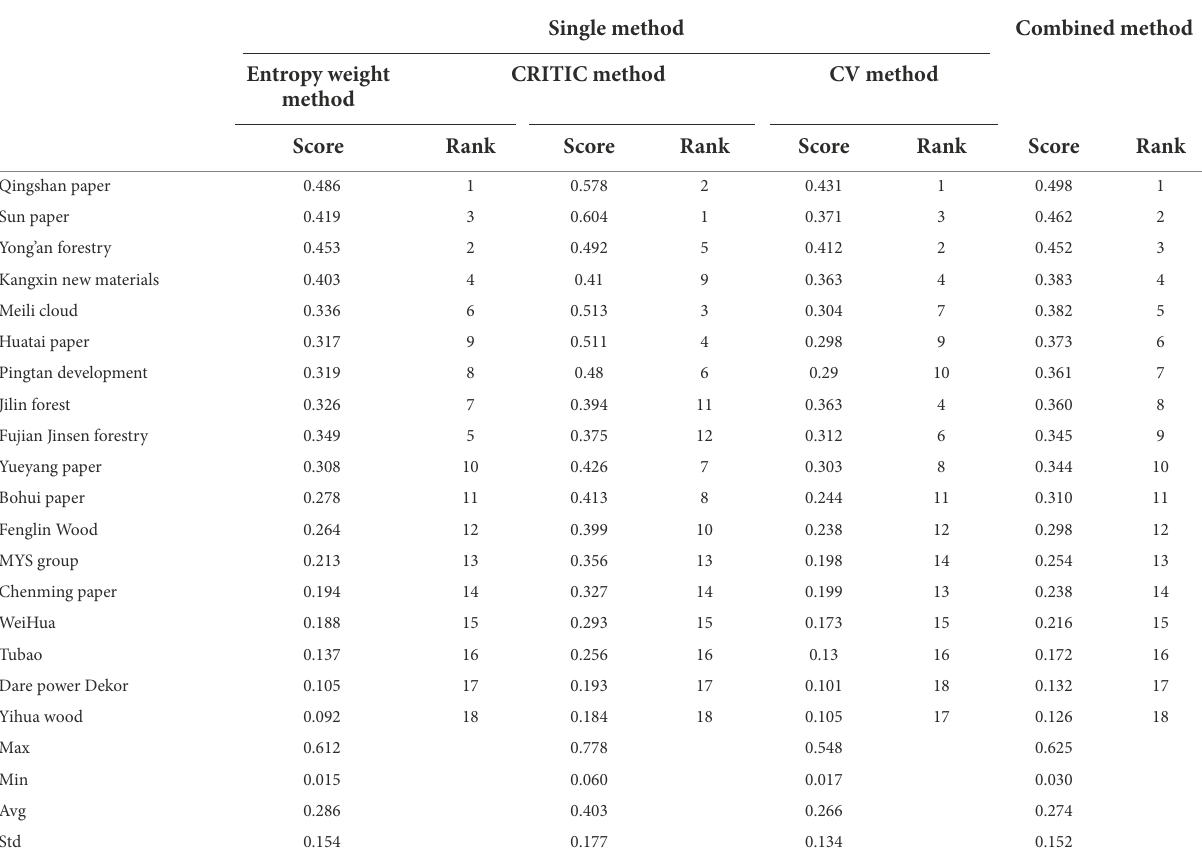
TABLE 3 Score of forestry